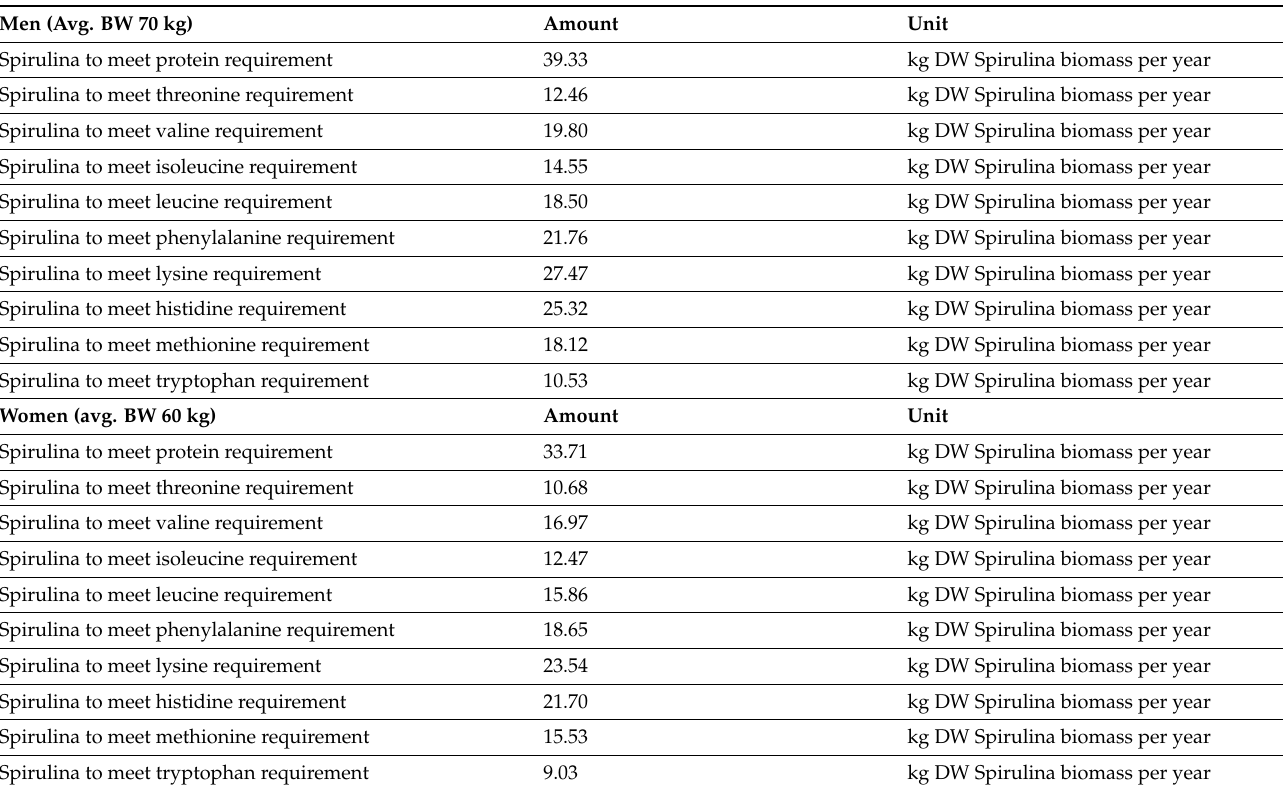
Table 3. Required intake of Spirulina biomass to meet recommended dietary allowance of protein and EAA, men and women.